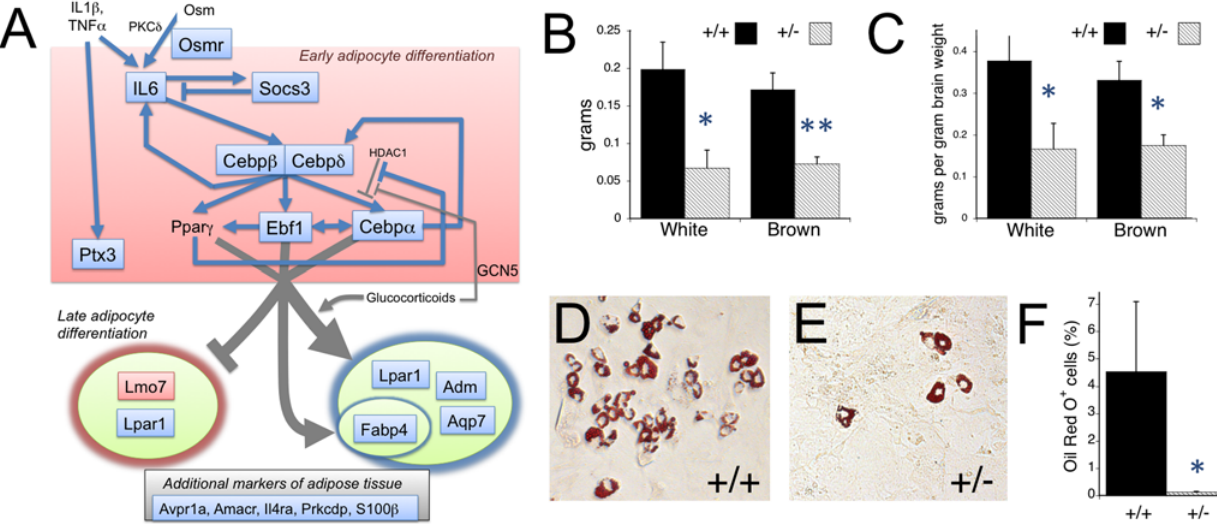
Figure 6. Alterations in adipogenesis in Nipbl + / 2 mice. (A) Gene regulatory network underlying adipogenesis. The adipogenic conversion of pre-adipogenic mesenchyme is under the control of a network of cross-regulating transcription factors, notably C/EBP b , C/EBP a , C/EBP d , PPAR c , and Ebf1 [67,68,76]. Input into this pathway can come from adipogenesis-promoting growth factors, such as interleukin 6 (IL6), or pharmacological agents such as glucocorticoids and PPAR c agonists [81,82]. A variety of other downstream genes have been identified as markers of early and late adipogenesis. Genes that were observed to be down-regulated in Nipbl + / 2 MEFs are highlighted in blue; those up-regulated are highlighted in pink. (B,C) Nipbl + / 2 mice are depleted in both white and brown fat. Scapular fat pads were dissected from adult male mice (206–630 days postnatal), divided into brown and white portions, and weighed (B). In (C), these weights have been normalized to brain weight, to correct for overall body size differences between wildtype (N=11) and mutant (N=9) mice. Both panels indicate that Nipbl + / 2 mice are substantially depleted in fat. (*=P , 0.05, **=P , 0.01, Student’s t-test). (D–F) Reduced spontaneous adipogenesis in Nipbl + / 2 MEFs. To determine whether mutant mesenchymal cells are intrinsically defective in adipogenic differentiation, wildtype (D) and Nipbl + / 2 (E) MEFs were cultured at confluence for 8 days, which allows for spontaneous adipocyte differentiation by a fraction of the cells, and fat-accumulating cells were visualized by Oil Red O staining. (F) summarizes data on the fraction of Oil Red O-positive cells observed in 9 independent MEF lines ( . 21,000 cells counted per line), from 4 wildtype and 5 Nipbl + / 2 mice (P , 0.05, Mann-Whitney Rank-Sum test).